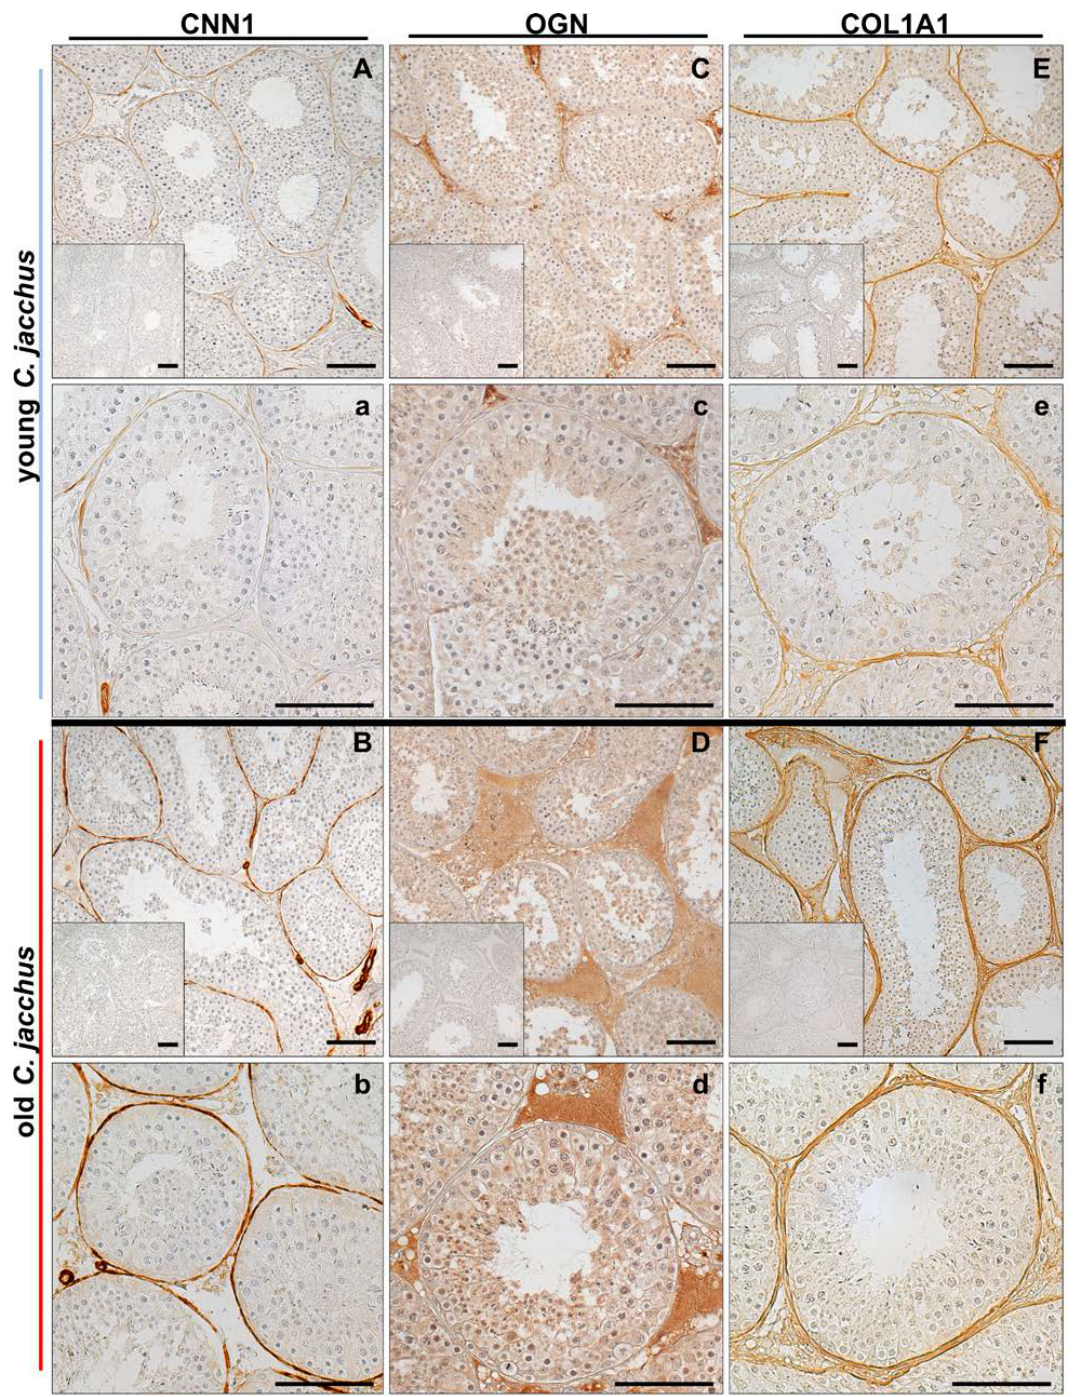
Figure 6. Representative light micrographs of immunohistochemistry. Testicular sections from young (2–3 years) and old (10–12 years) C. jacchus were stained with specific antibodies against CNN1, OGN and COL1A1. CNN1 staining was found in most peritubular cells from young C. jacchus ( A , a , (higher magnification)). In old C. jacchus, CNN1 was expressed in all peritubular cells ( B , b (higher magnification)). OGN was detected mainly within the interstitial space of testes of young C. jacchus ( C , c (higher magnification)). The level increased in the testes of old C. jacchus ( D , d (higher magnification)). COL1A1 was detected in peritubular cells from young ( E , e (higher magnification)) and old ( F , f (higher magnification)) C. jacchus. In old individuals, COL1A1 expression increased in the interstitial space. Nuclei were slightly stained with hematoxylin. Inserts: negative controls. Scale bars = 100 µ